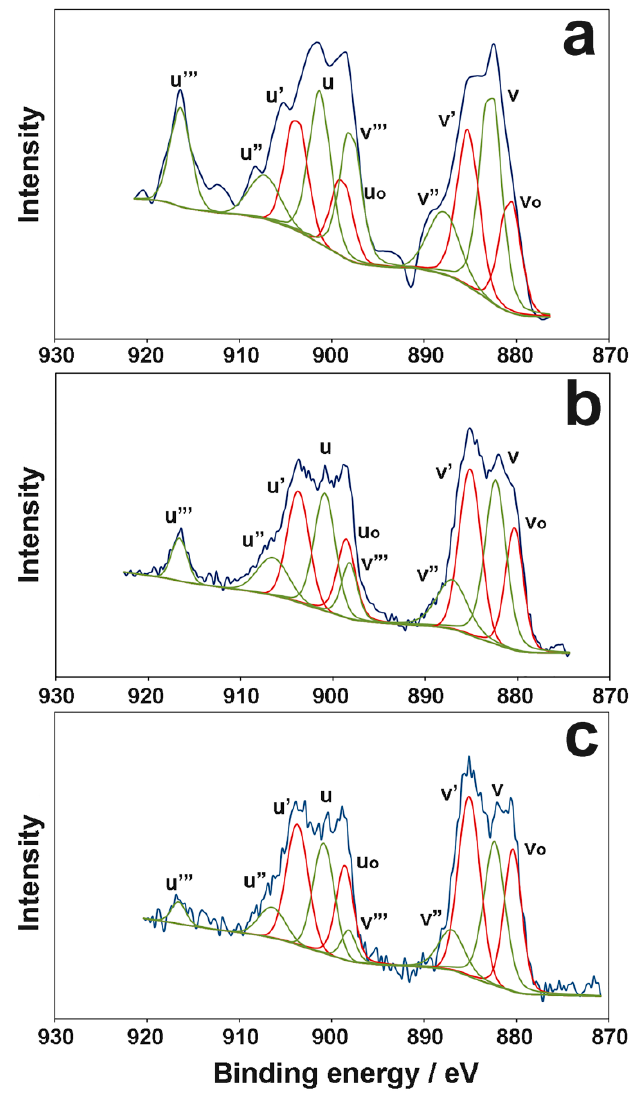
Figure 4. (Color online) Ce3d photoelectron spectra for as-grown 10Sc1 Се SZ crystal after 30 min ( a ), 1 h ( b ) and 48 h ( c ) in the test chamber. The experimental spectra (blue lines) were fitted using V-U, V”-U” and V”’-U”’ doublets from Ce 4+ (green lines) and Vo-Uo, V’-U’ doublets from Ce 3+ (red lines).